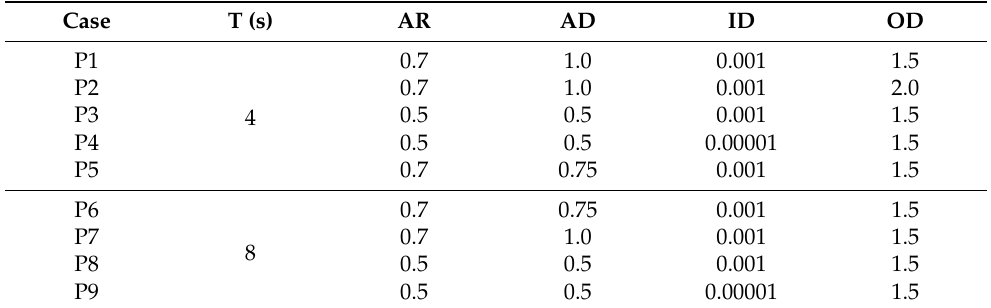
Table 4. Coefficients of the simulation cases for the sensitivity tests for H = 1.0 m, T = 4 s, and 8 s, conducted for a buoy with R = 0.25